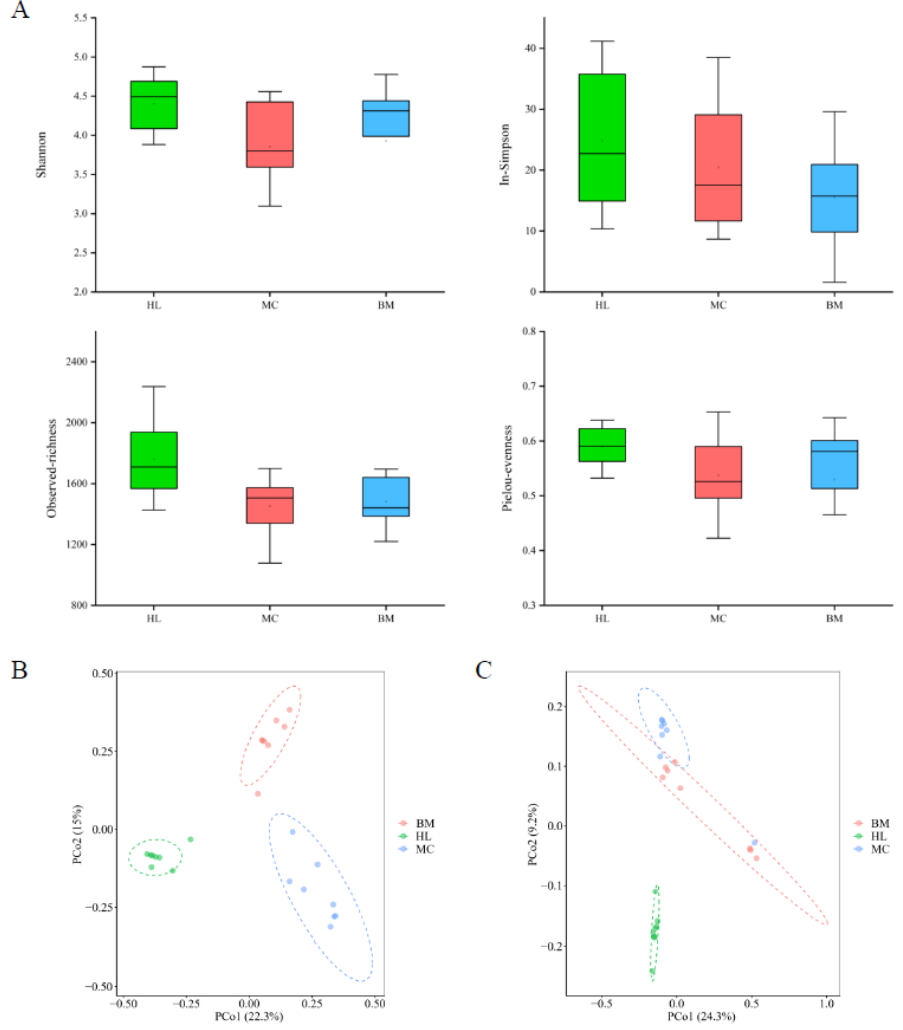
Figure 2. Alpha diversity ( A ) and principal coordinates analysis (PCoA) of fungal communities in the three wetland ecosystems. PCoA based on Bray–Curtis ( B ) and Jaccard ( C ) distance. HL, MC and BM represent the Huahu Lake wetland, Mangcuo Lake wetland and Baima Snow Mountain wetland, respectively.